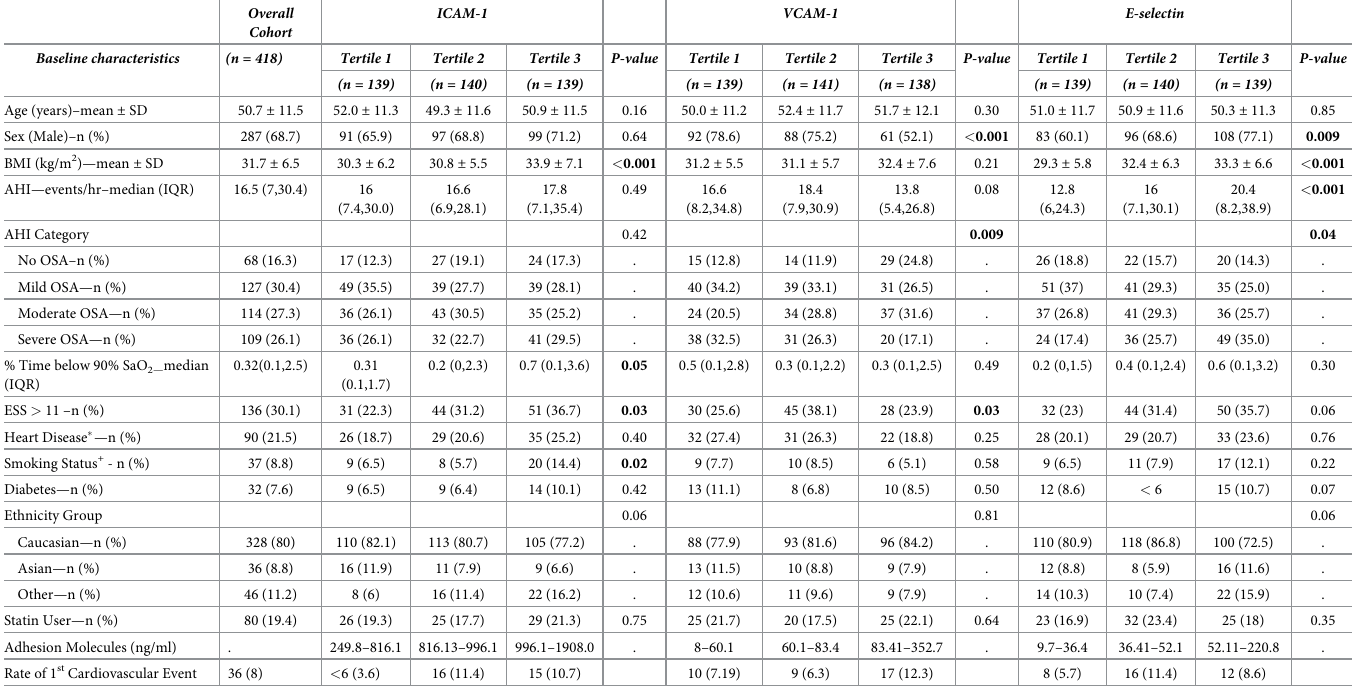
Table 1. Patient characteristics by adhesion molecule tertiles (n = 418).